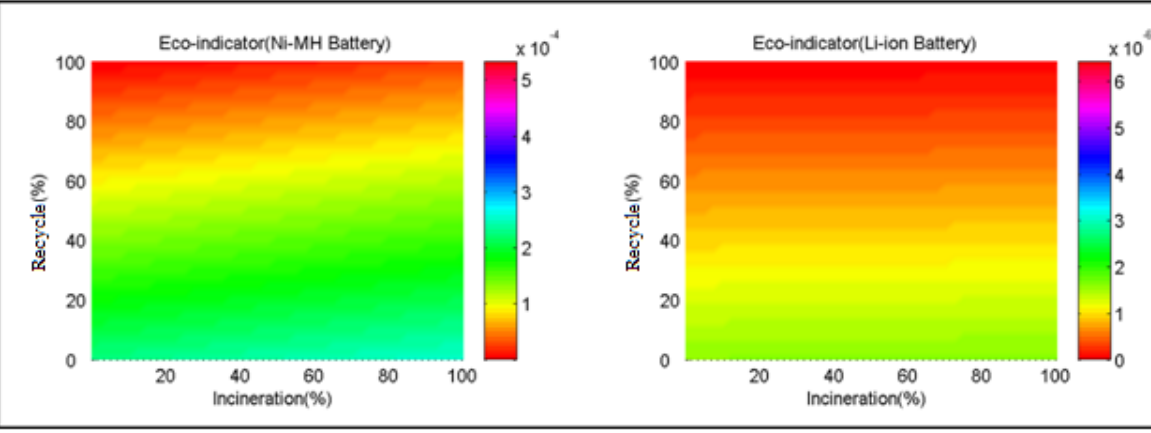
Figure 7. Influence of recycle rate and incineration rate on the Eco-indicator of the two selected